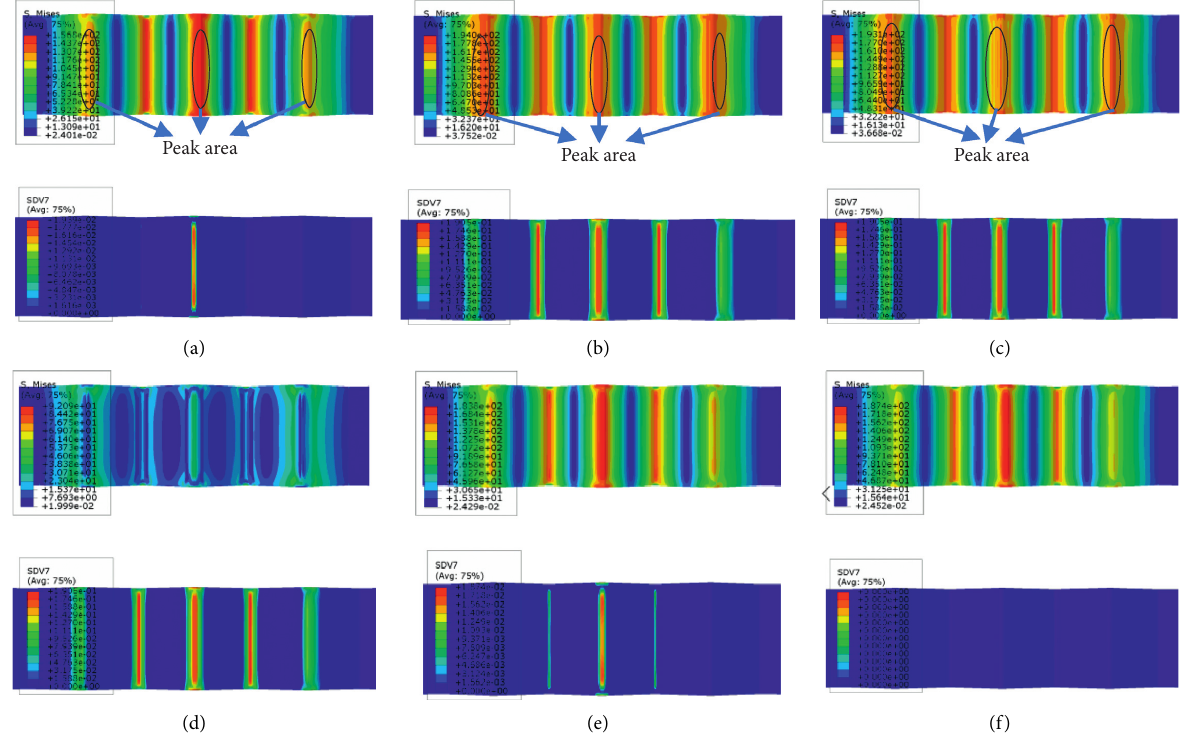
Figure 15: SMA ripple von Mises stress cloud (a, b, c) detwinned martensite cloud (d, e, f): (a) b point cloud; (b) c point cloud; (c) d point cloud; (d) e point cloud; (e) f point cloud; (f) g point